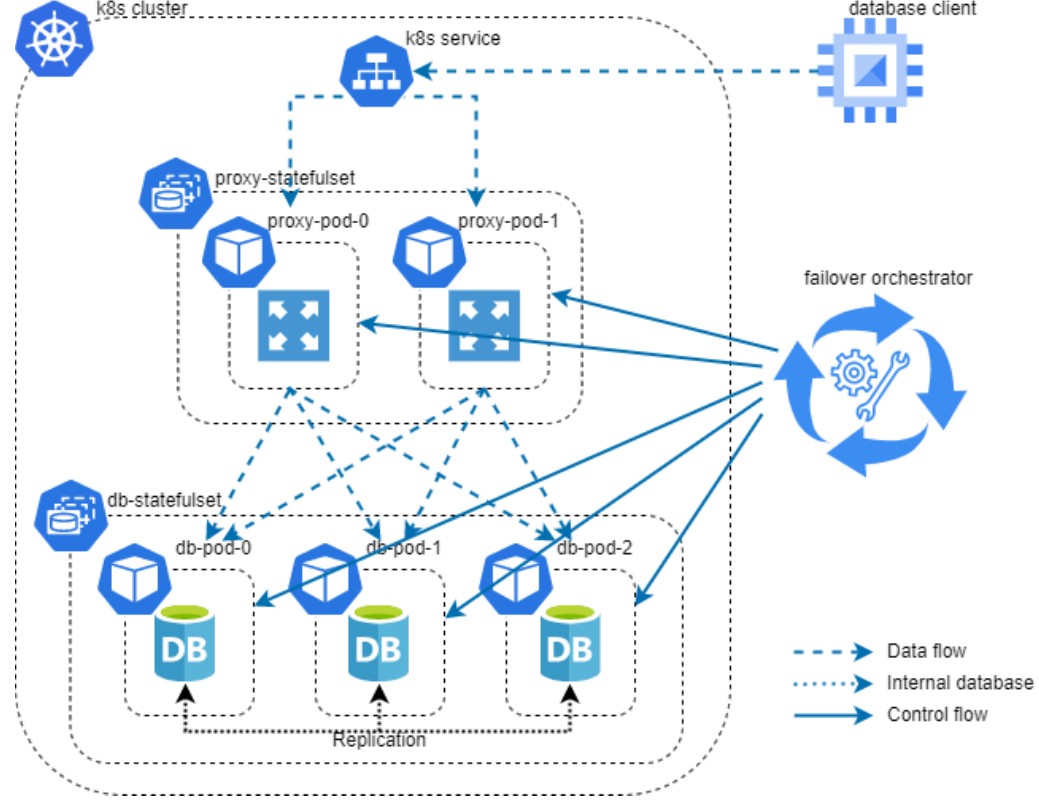
Figure 4. The investigated architecture of the multi-master database cluster.